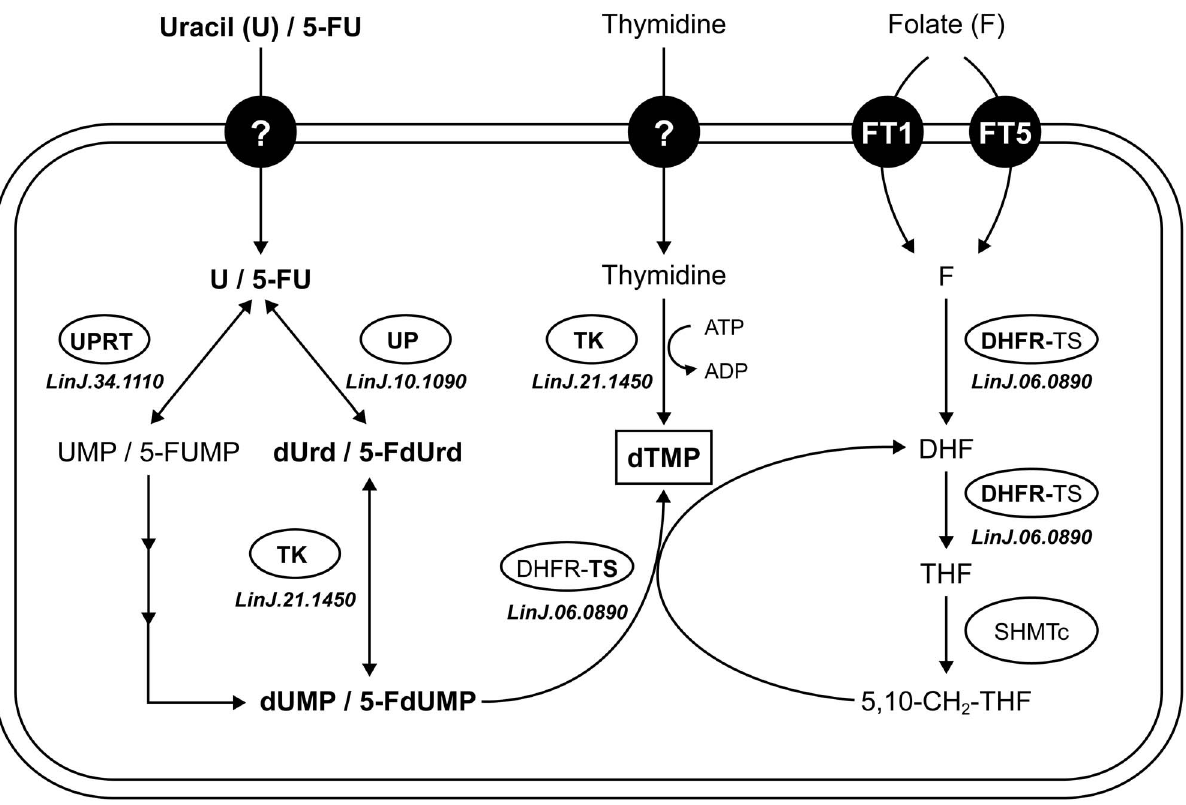
Figure 5. Pyrimidine metabolism and linkages with folate metabolism in Leishmania . Uracil, after its importation by a non-identified transporter, is metabolized into uridine monophosphate (UMP) by the action of the uracil phosphoribosyl transferase (UPRT, LinJ.34.1110 ) or into deoxy-uridine (dUrd) by the uridine phosphorylase (UP, LinJ.10.1090 ). The thymidine kinase (TK, LinJ.21.1450 ) is involved in synthesis of deoxy-uridine monophosphate (dUMP) but also deoxy-thymidine monophosphate (dTMP). The dUMP produced will lead to dTMP through the action of the bifunctional enzyme dihydrofolate reductase-thymidylate synthase (DHFR-TS). The drug 5-FU is also transported by the uracil transporter and can be metabolized by UPRT, UP and TK. Abbreviations: F, folate; DHF, dihydrofolate; THF, tetrahydrofolate; SHMTc, cytosolic serine hydroxymethyl- transferase; U, uracil; 5FU, 5-fluorouracil; 5-FdUrd, 5-fluoro-deoxy-uridine; 5-FUMP, 5-fluoro-uridine monophosphate; 5-FdUMP, 5-fluoro-deoxy-uridine